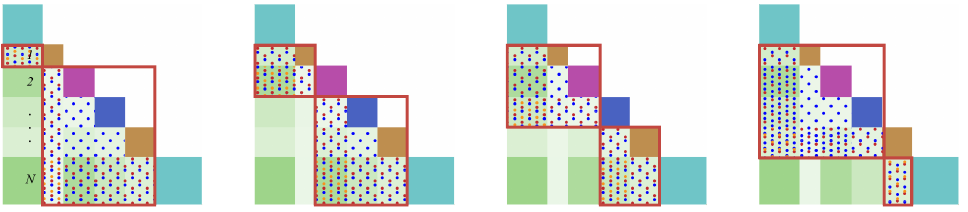
Figure 10. Examples of conceptual similarities used in the combined method (Plane + Line + Point). Each red square represents a topic segment. The light green squares with blue dots indicate the conceptual similarities used in the Plane method. The light green squares with red dots indicate the conceptual similarities used in the Line method. The light green squares with orange dots indicate the conceptual similarities used in the Point